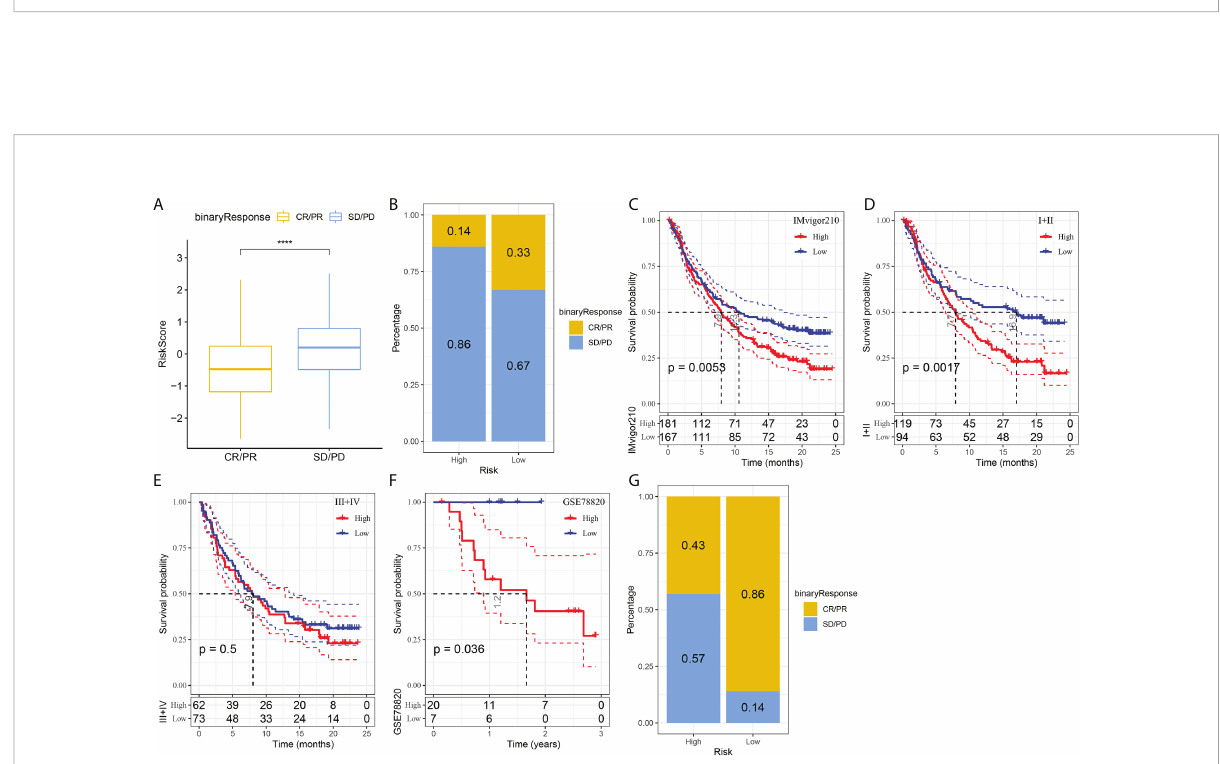
FIGURE 7 The responsiveness of risk score to PD-L1 blockade immunotherapy in IMvigor210 cohort. (A) Differences in risk scores among immunotherapy responses in the IMvigor210 cohort; (B) Distribution of immunotherapy responses among risk score groups in the IMvigor210 cohort; (C) Prognostic differences among risk score groups in the IMvigor210 cohort; (D) Prognostic differences between risk score groups in early stage patients in the IMvigor210 cohort; (E) prognostic differences between risk score groups in advanced patients in the IMvigor210 cohort; (F) prognostic differences in risk score groups in the GSE78220 cohort; (G) Distribution of immunotherapy responses among risk score groups in the GSE78220 cohort. ****P < 0.0001.